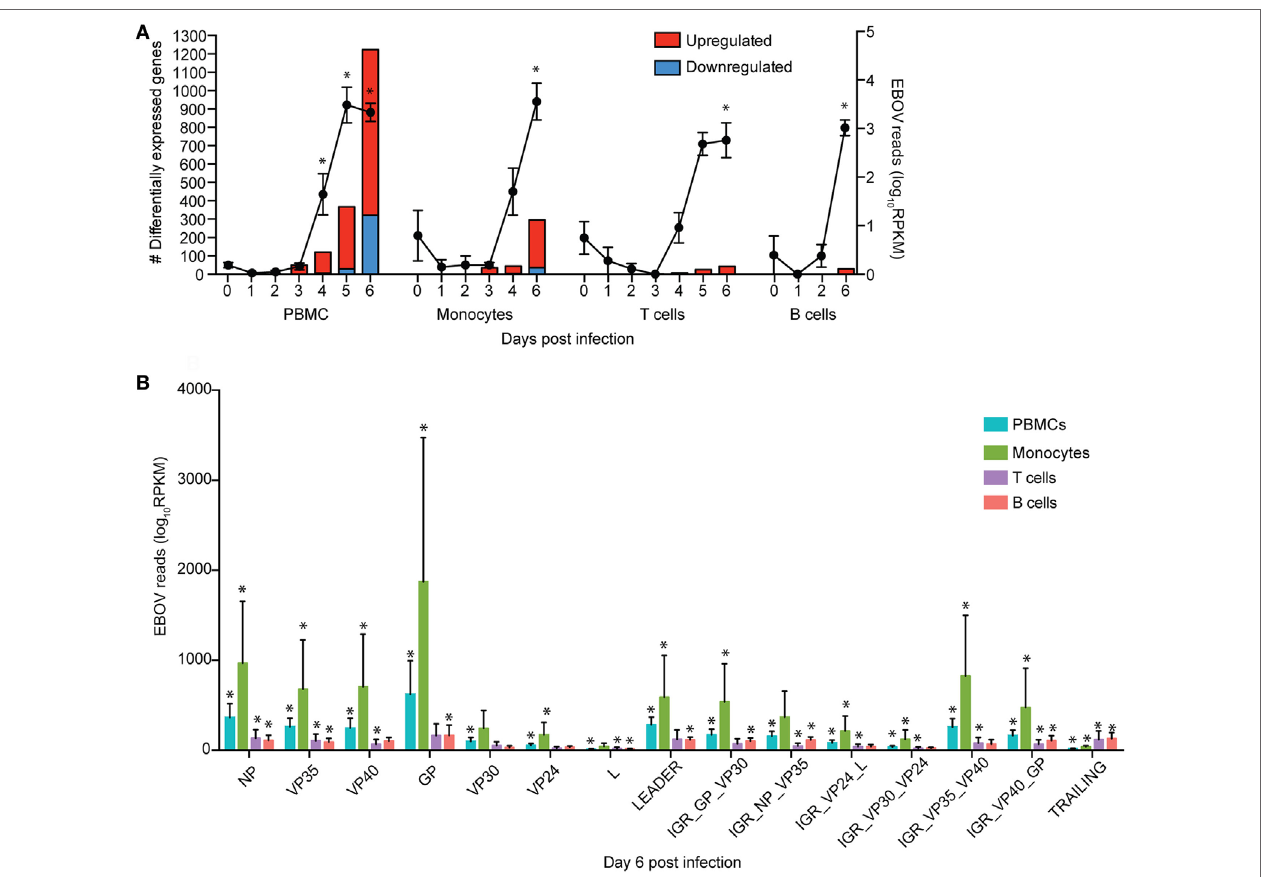
FigUre 1 | Monocytes support ZEBOV-Makona replication and are major contributors of inflammation. (a) Bar graph depicts number of protein coding differentially expressed genes (DEGs; defined as those ≥ 2 fold change and false discovery rate (FDR) corrected p -value ≤ 0.05 compared to 0 DPI) that have human homologs (red indicates upregulated while blue indicates downregulated DEGs) in peripheral blood mononuclear cells (PBMC), monocytes, T cells, and B cells. Line graph represents number of normalized viral transcripts (RPKM); mean ± SEM are shown; * p ≤ 0.05 compared to day 0. (B) RPKM normalized RNA sequencing reads mapping to each ZEBOV open reading frame (ORF), intergenic region (IGR), as well as leader and trailing sequences 6 DPI within PBMC, monocytes, T-cells, and B-cells. FDR adjusted p -value was obtained following EdgeR analysis; mean ± SEM are shown; * p ≤ 0.05 compared to day